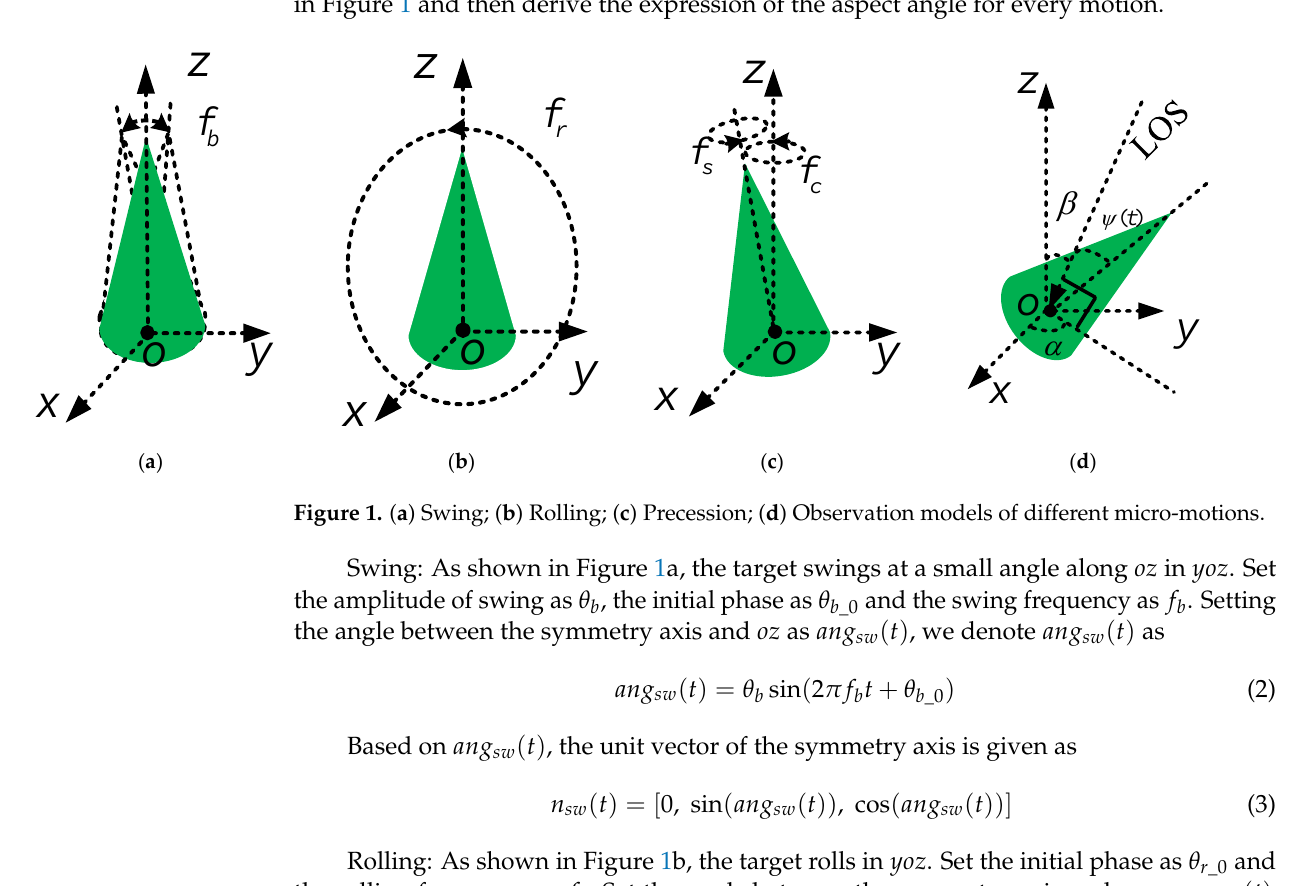
Rolling: As shown in Figure 1b, the target rolls in yoz . Set the initial phase as θ r _0 and the rolling frequency as f r . Set the angle between the symmetry axis and oz as ang rol ( t ) , and it is written as